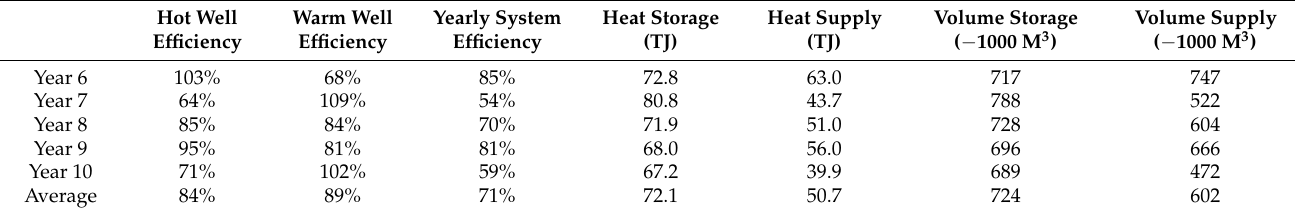
Figure 14. Temperature of the hot and warm well over five years (2010–2015). The last five years of ten years of modeling are shown, as the first five years were used to heat up the wells starting from background temperature (12 °C). After five years, the system has reached an equilibrium state. The arrow shows the switch to a different operating strategy (see text) and a decrease in the warm well temperature. Table 7. Overview of the HT-ATES performance over five years, starting from the sixth year that the system is running after it has been warmed up in years